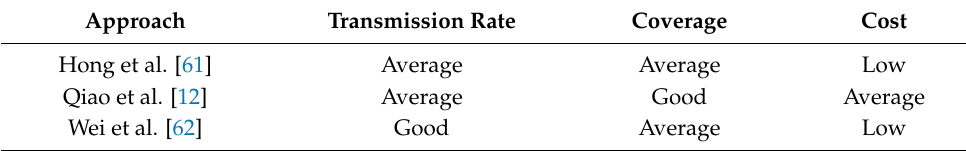
Table 7. Summary of existing mmWave-based approaches in 5G